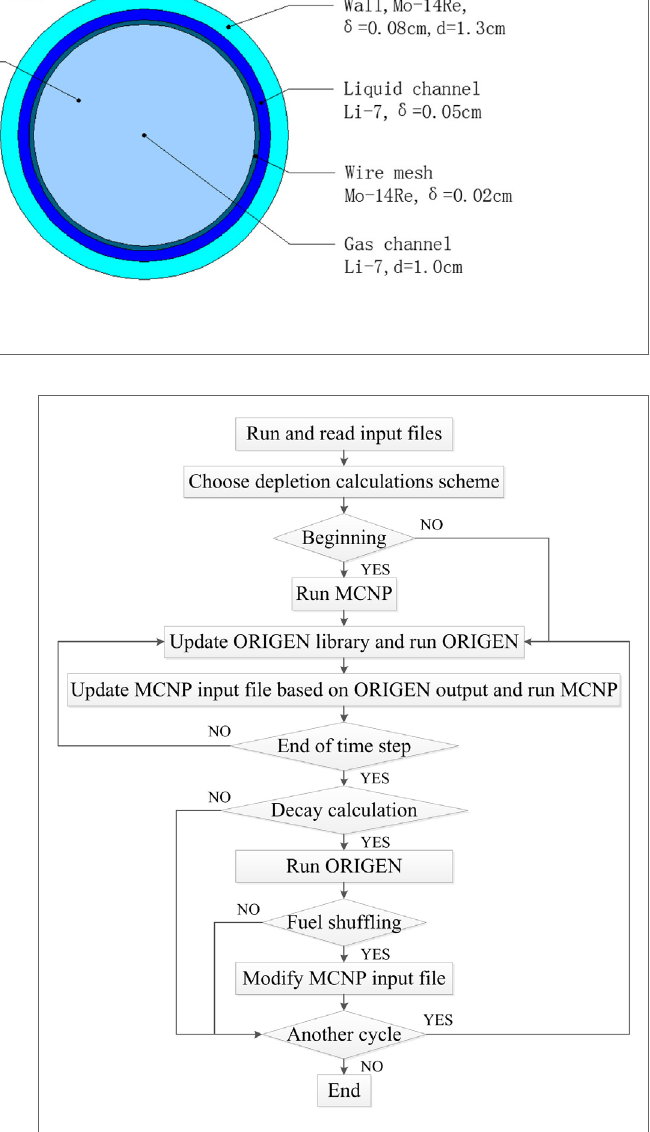
FigUre 5 | Flow chart of MCORE